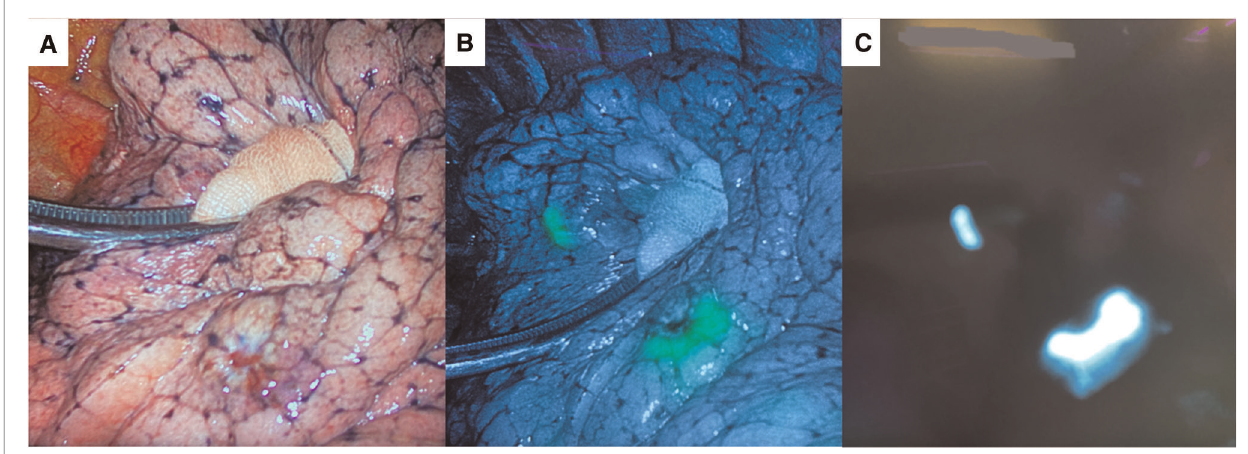
FIGURE 3 | ( A ) Intraoperative fi eld. Metastatic nodules: infrared ( B ) and white light ( C ) signal